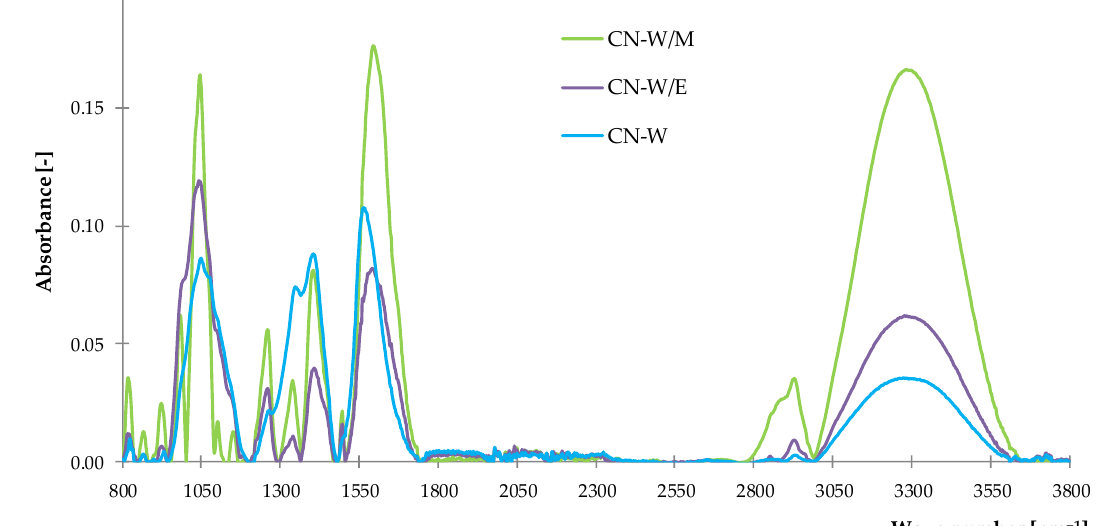
Figure 2. The FTIR spectra of peppermint freeze-dried extracts. Table 2. Characteristic functional groups registered by FTIR analysis of freeze-dried extracts. Adapted from Ref. [80].